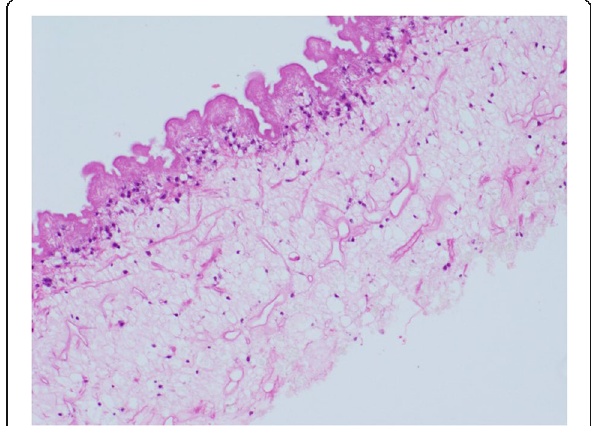
Fig. 2 Neurocysticercal cyst showing the characteristic three layered wall: a cuticular layer with hair-like microtrichia, middle cellular layer, and an inner reticular layer with focal calcification